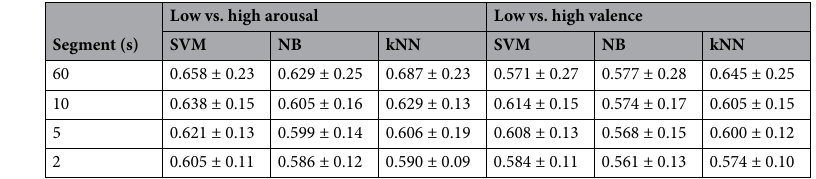
Table 2. Classification accuracy for low vs high arousal/valence using DWT-based feature extraction using 32 EEG channels, proven with three classifiers and different signal segment sizes.